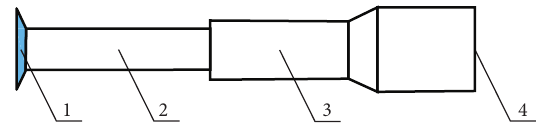
Figure 3: Profile of ACDRD. (1) Injection outlet; (2) injection box; (3) air duct; (4) forcing fan